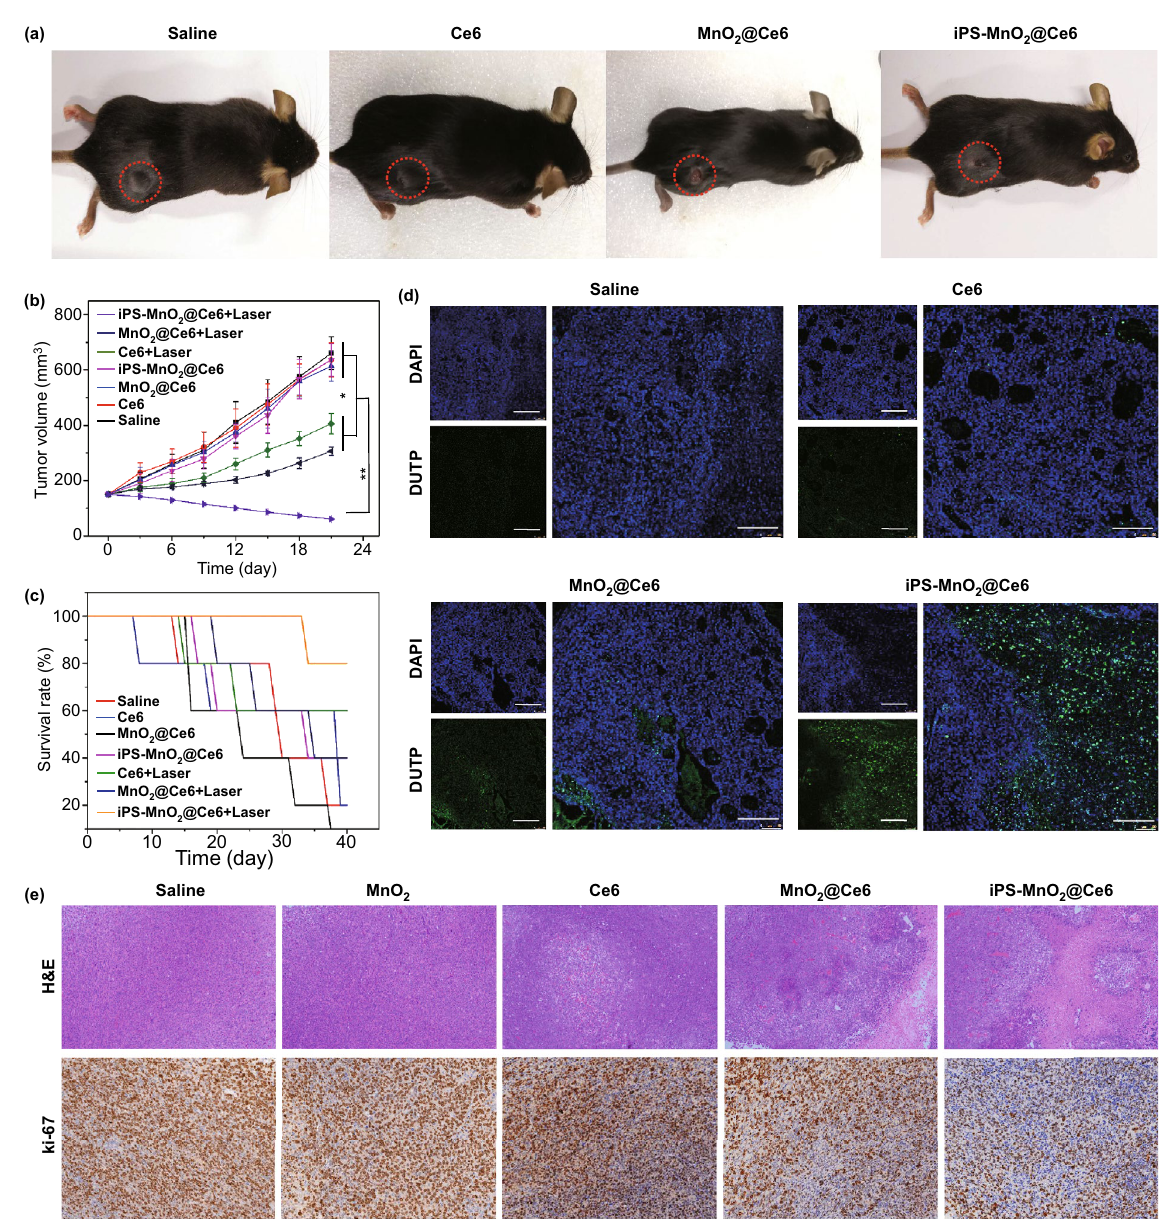
Fig. 7 Anti-tumor activity of iPS-MnO 2 @Ce6 in vivo. a Representative photographs of the mice on 14th day post-combination therapy. b Changes of tumor volume with time increase in various groups after laser irradiation ( n = 5 in per group). Statistical significance was calculated via two-tailed student’s t test. P value: * P < 0.01, ** P < 0.001. c Survival curves of the mice in each group after different treatments ( n = 5 in per group). d Representative TUNEL analysis of apoptosis in the tumor sections after different treatments. Scale bars are 100 μm. e Representative images of H&E and Ki67 stained tumor slides from the mice after different treatments. Magnification, 100 × and 200 ×